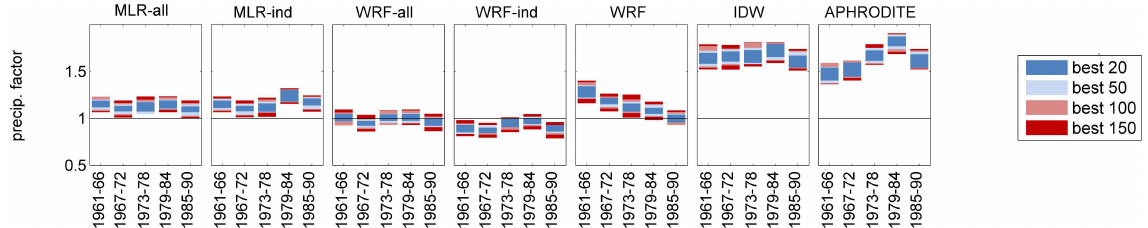
Fig. 11. Variation of the precipitation bias factor by time period for the subcatchment Cholma as an example. The data are the same as also shown in Fig. 10, but they are sorted in a different way in order to better demonstrate the variation by time period (particularly noticeable for the WRF and APHRODITE precipitation data